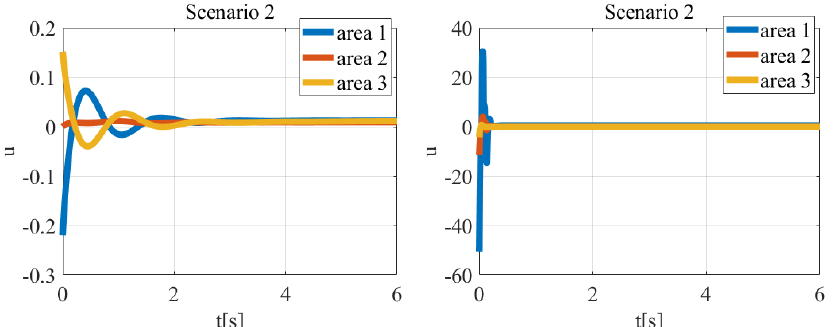
Figure 13. Control signals u ( t ) with LQR ( left figure) and fuzzy controller ( right figure) for different areas—scenario 2.